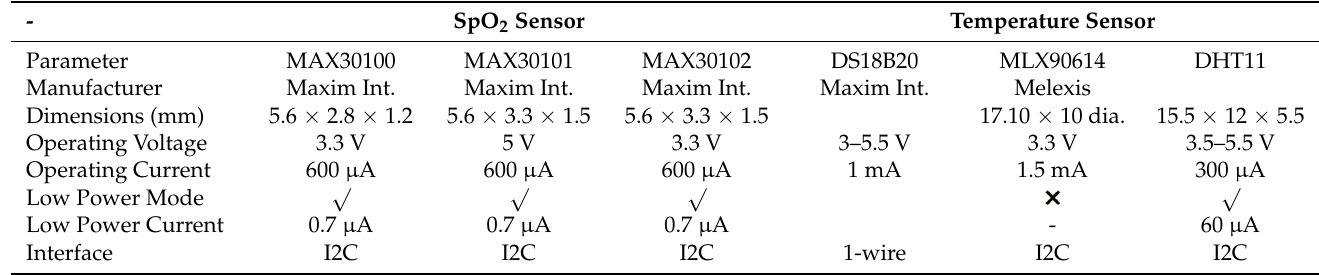
Table 4. SpO 2 and temperature sensor options ( that the feature is unavailable).